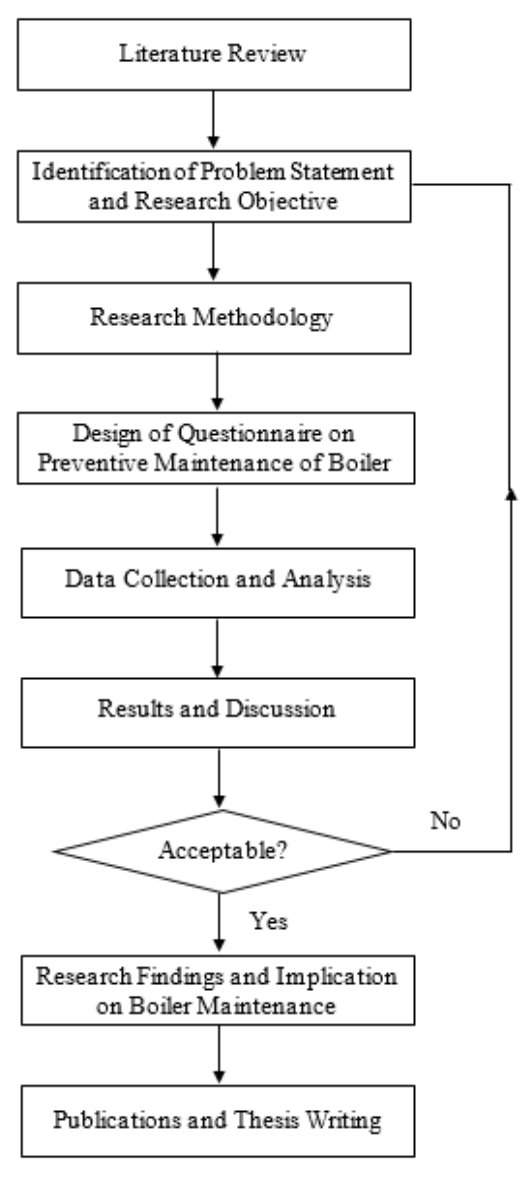
Figure 6: Research